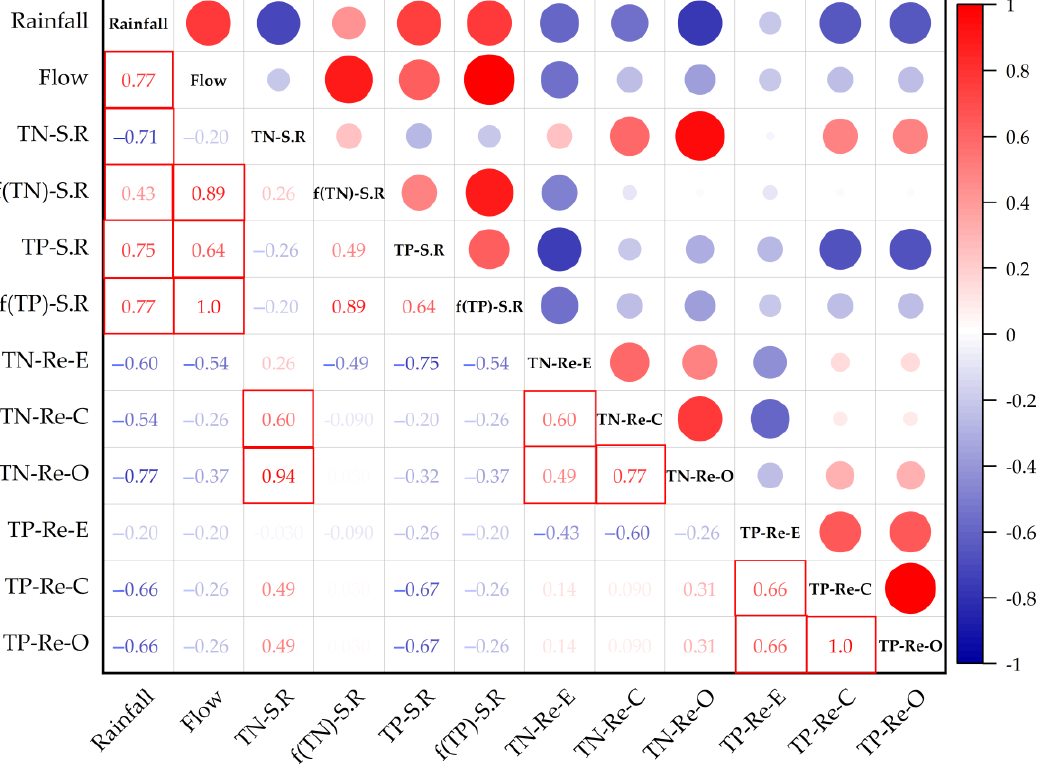
Figure 6. Correlation analysis of variables in the Sha River (S.R) and Yuqiao Reservoir (Re) in the high flow season of 2020. TN and TP represent concentrations of TN and TP; f (TN) and f (TP) represent the flux of TN and TP. A significant correlation is marked by the red boxes.